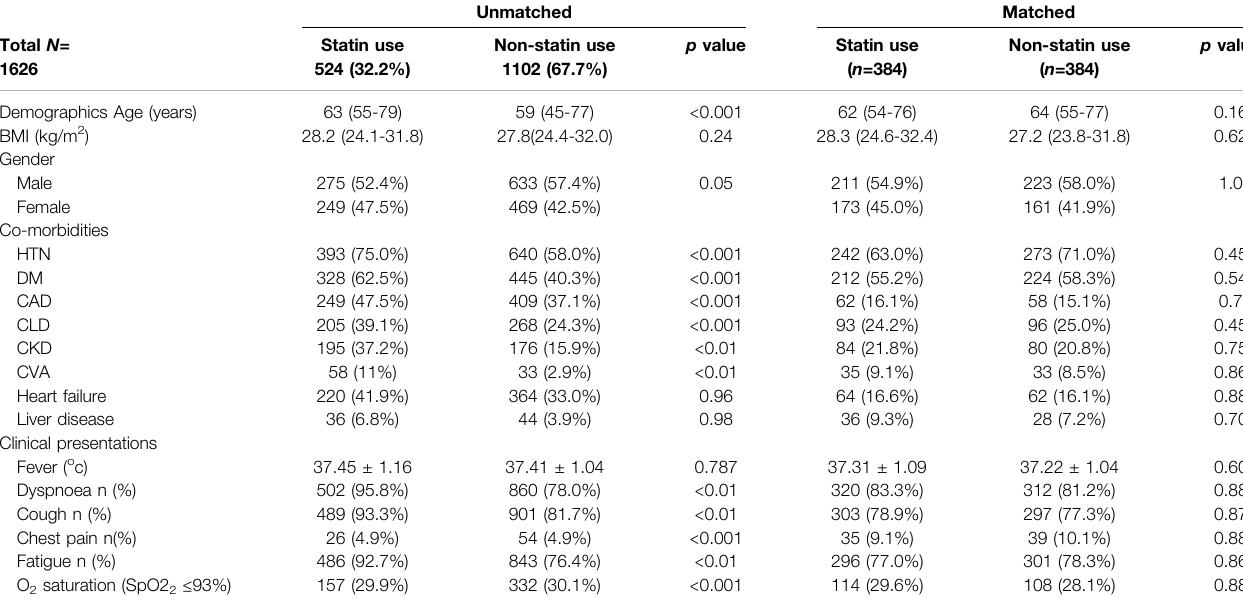
Unmatched Matched